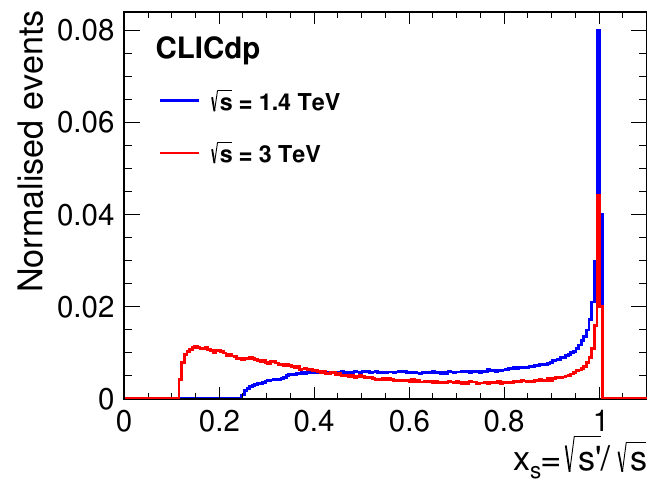
p s = 1 : 4 (3) TeV in blue (red), including QED